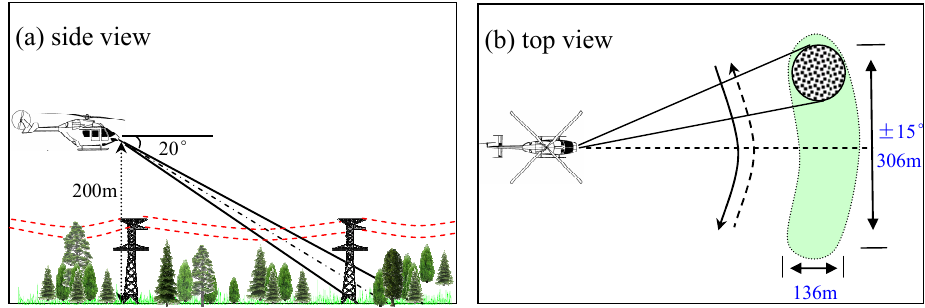
Figure 14. Experimental flight pattern. ( a ) Side view; ( b ) Top